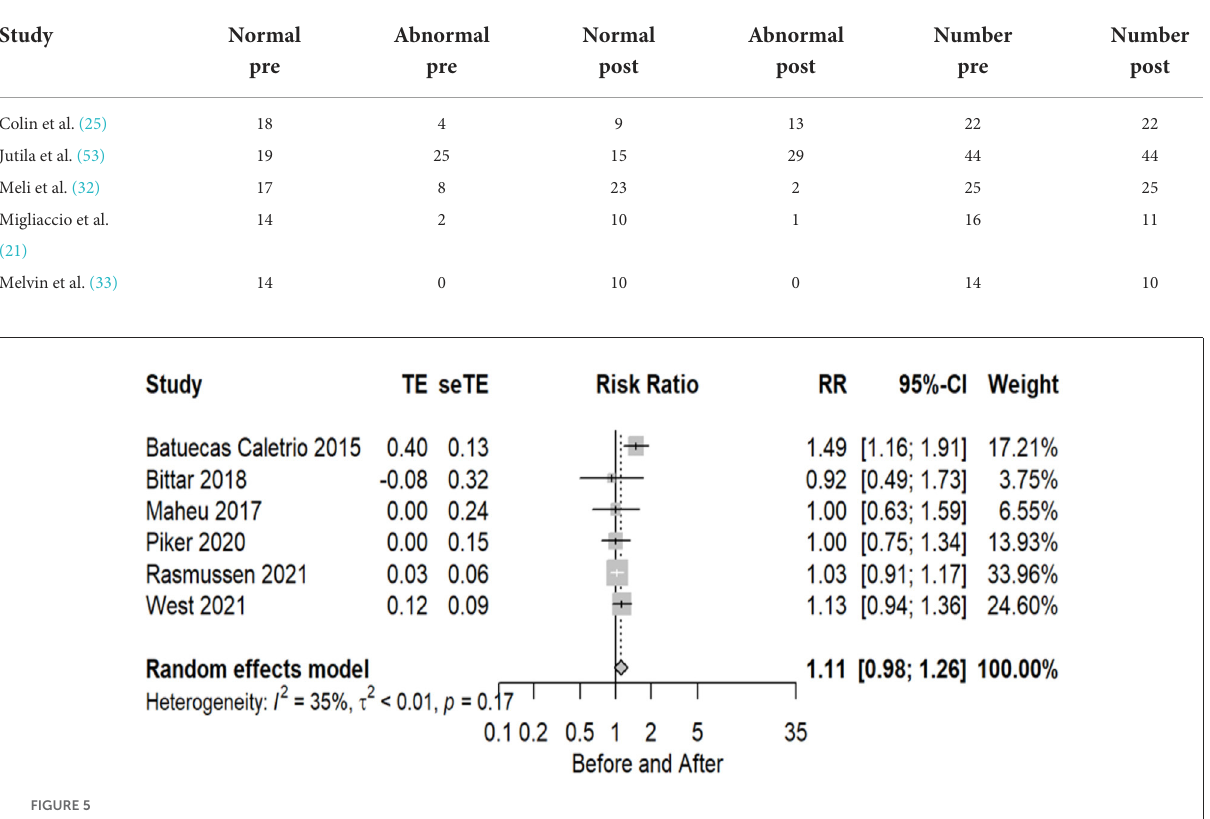
FIGURE5 Forest plot (showing relative effect sizes) for the VHIT